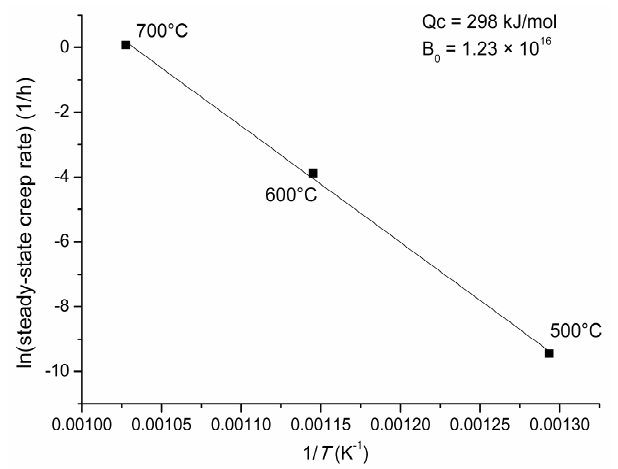
Figure 11. The diagram to determine the activation energy ( Qc ) at 319 MPa of the plasma-nitrided Ti-6Al-4V alloy.